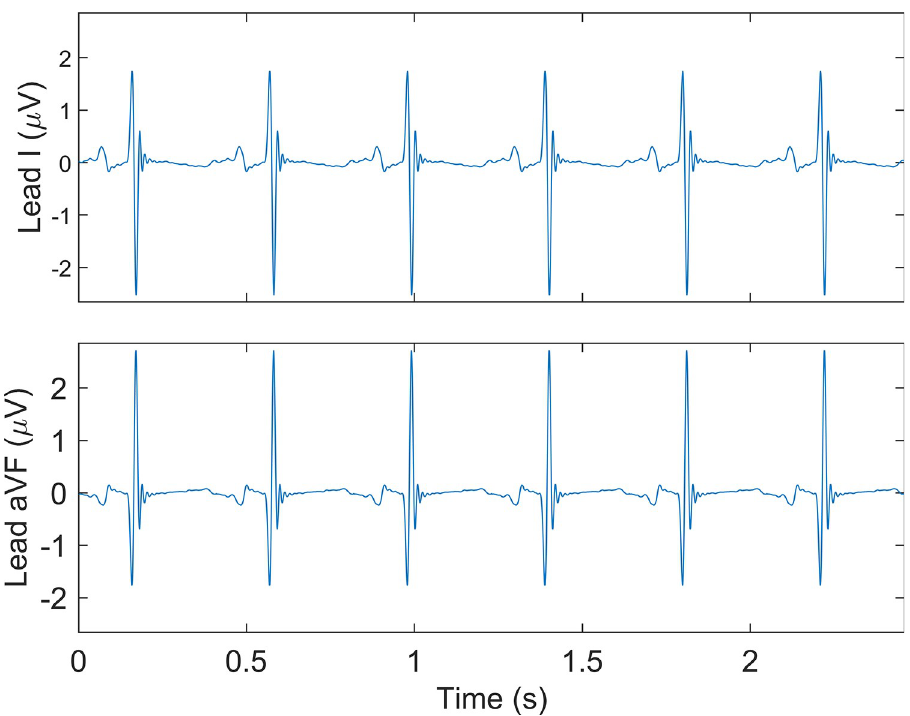
Fig 3. Example of a fetal electrocardiogram. Lead I and aVF. x-axis is time in seconds (s), y-axis is electric potential in microvolts ( μ V).